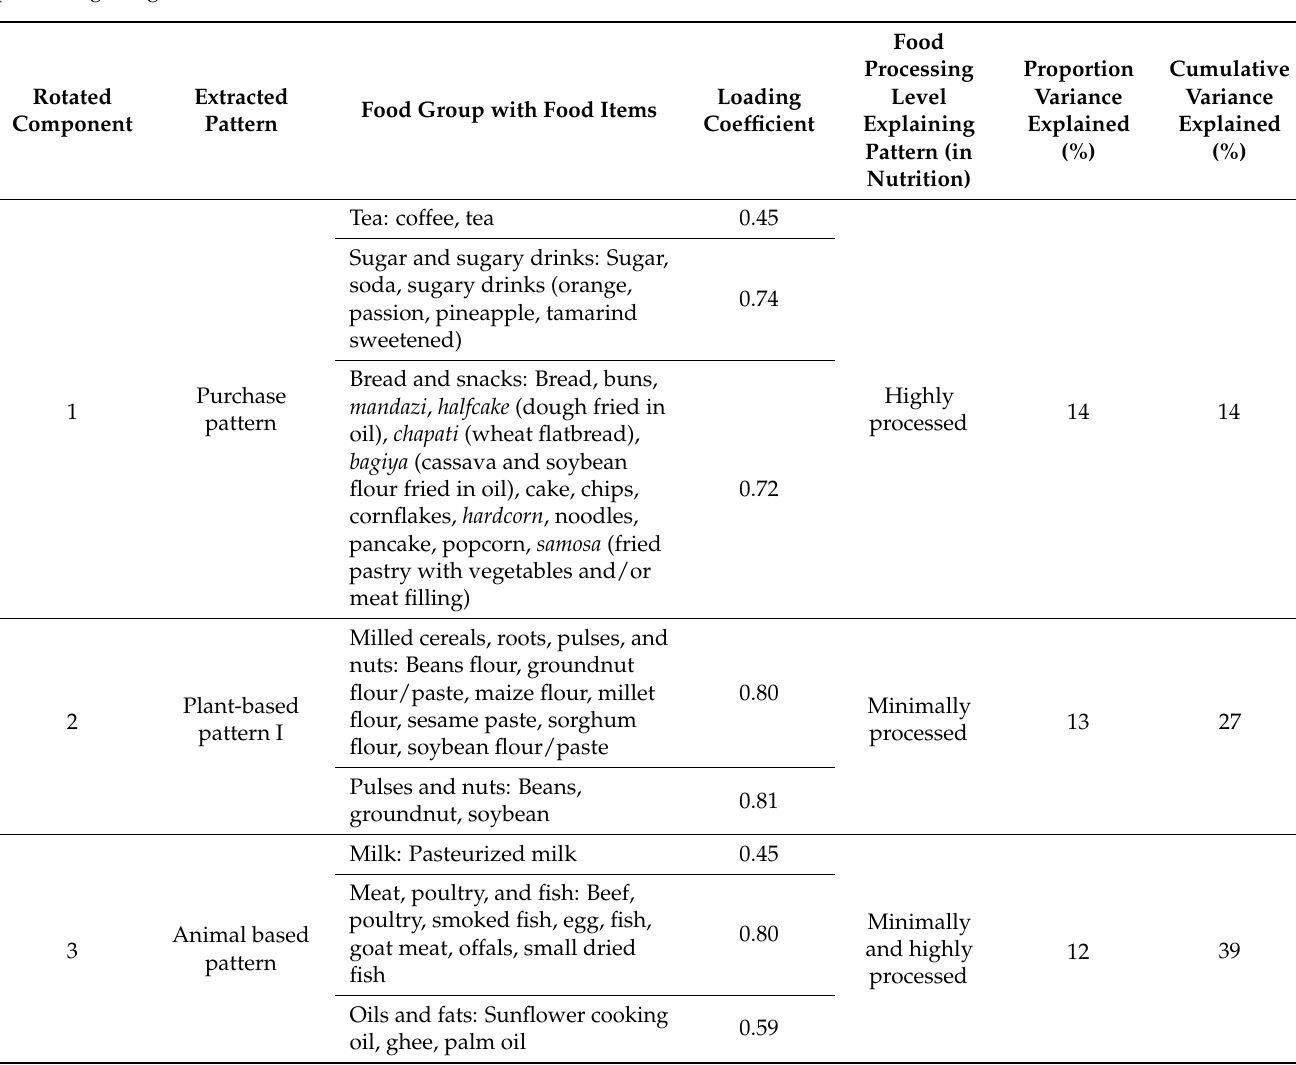
Table 5. Patterns extracted for women of reproductive age in Uganda based on 11 food groups and characterized by three food processing